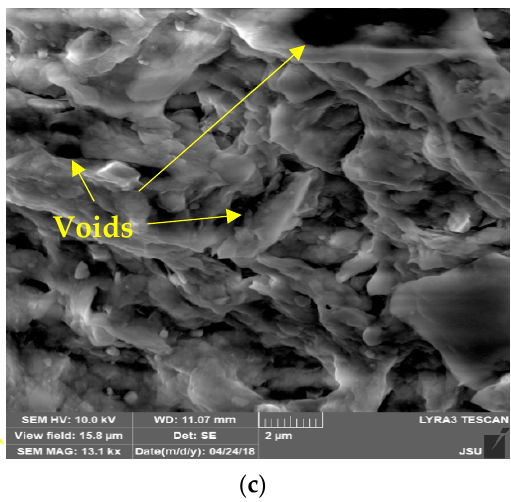
Figure 6. Change in pore space of Yazoo clay using SEM imaging after the sample subjected to ( a ) 3 wet-dry cycles ( b ) 5 wet-dry cycles ( c ) 7 wet-dry cycles.